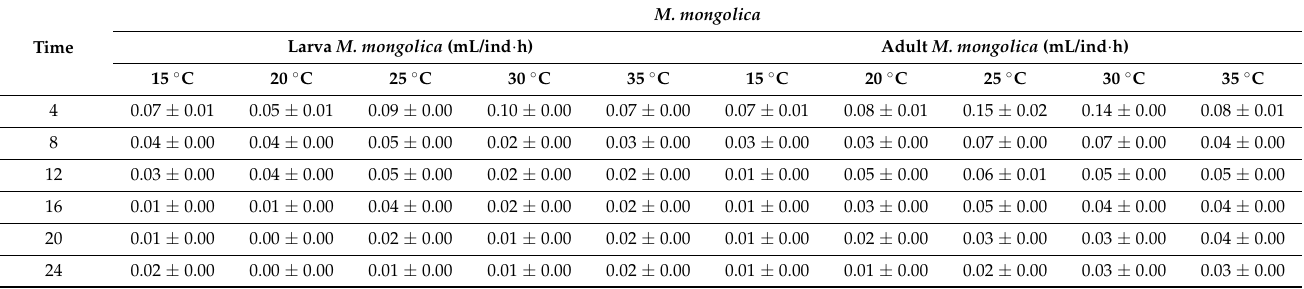
Table 2. Water filtration rates of M. mongolica at two age stages at different temperatures (data are listed as mean ± standard